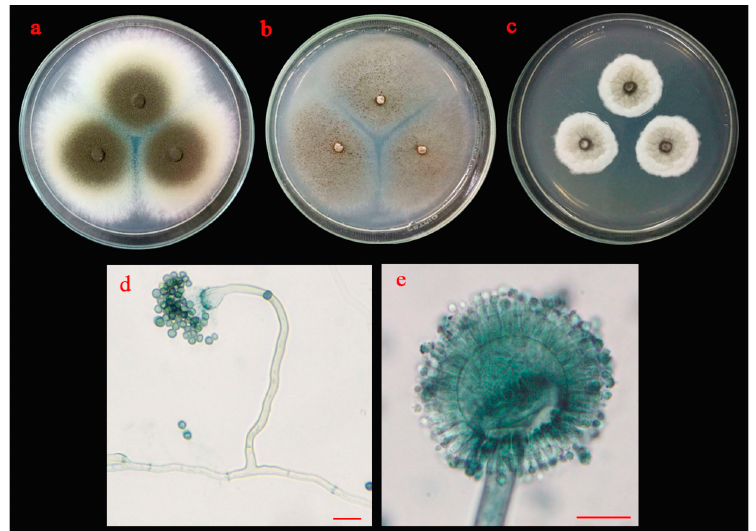
Fig. 6.(B). Morphological characteristics of ST02 isolate: colonies of ST02 isolate on three different media (a; PDA, b; MEA and c; CYA medium); sporangiophore with stolon (d) and conidia (e); the scale bar = 10 µm.